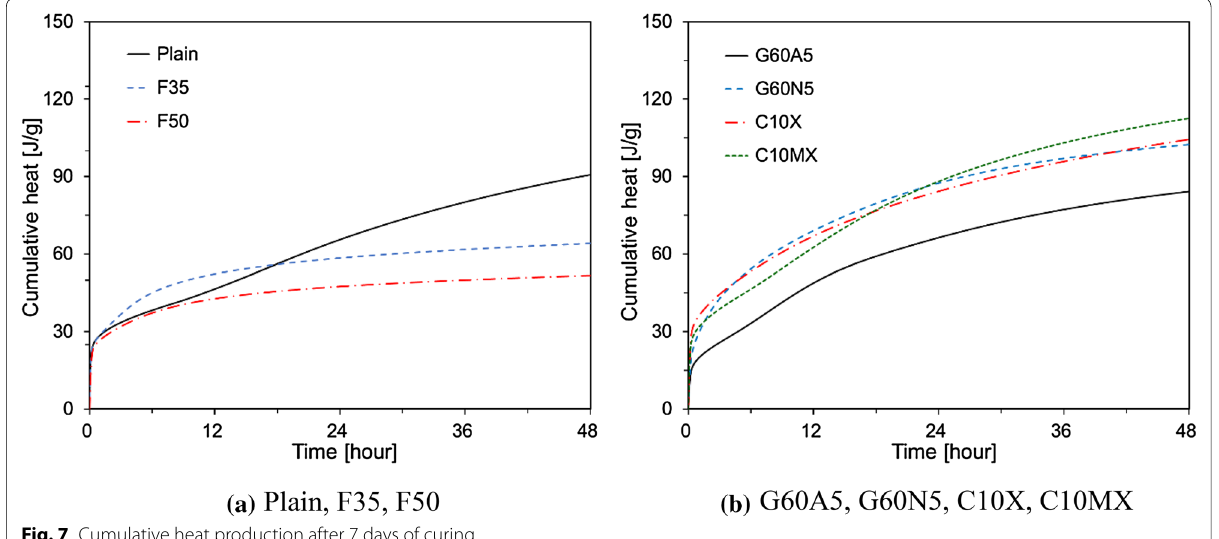
Fig. 7 Cumulative heat production after 7 days of curing.